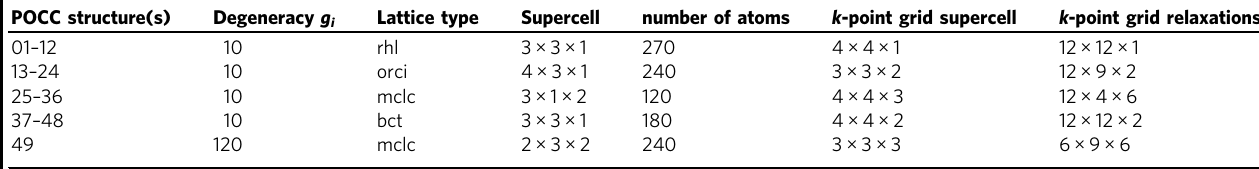
Table 2 DFT parameters for the APL calculations of the POCC derivative